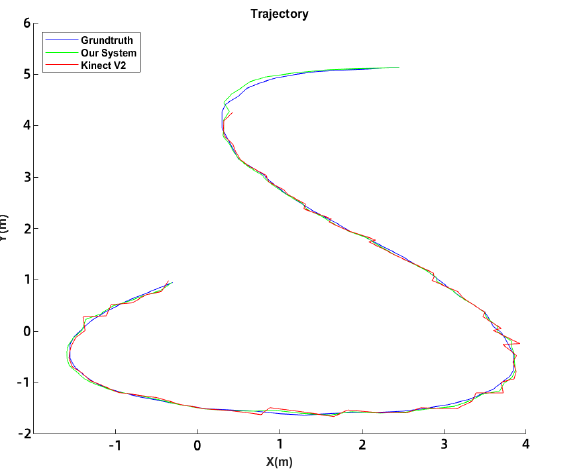
Figure 6. Tacking Trajectory.